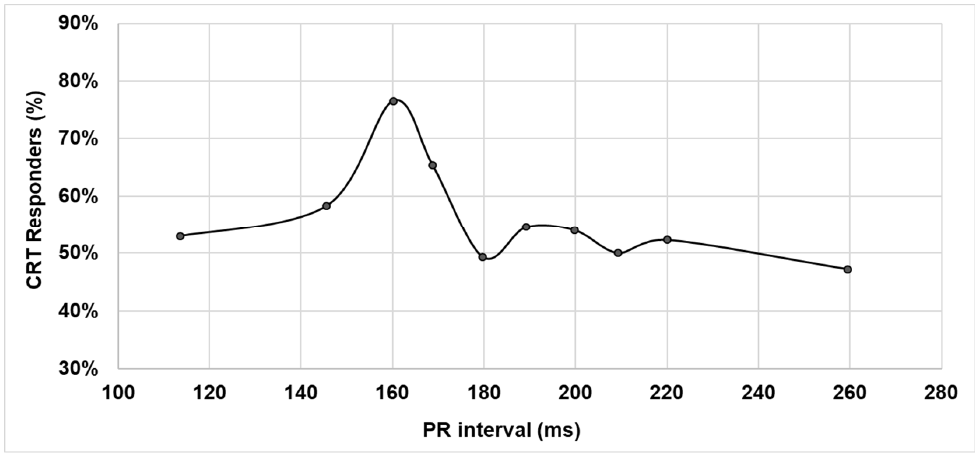
Figure 1. CRT response as a function of the PR interval in all patients.